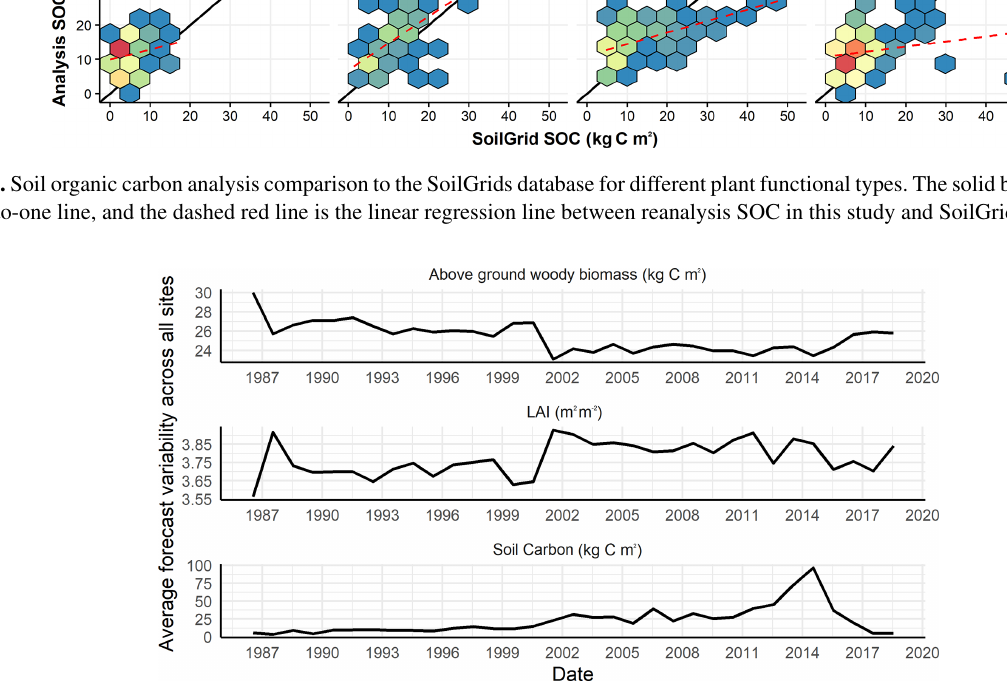
Figure 10. Average forecast variability (SD) across all sites and all pools at each time